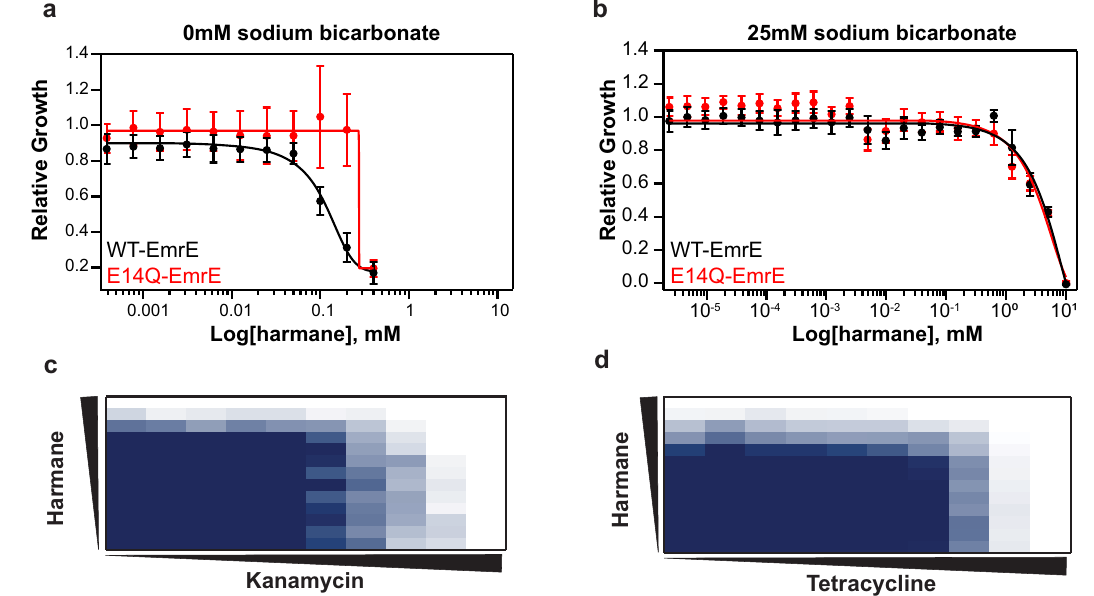
Fig. 6 | Harmane dissipates the proton gradient of bacterial cells. a , b Relative growth was plotted as a function of harmane concentration in the presence of 25mM sodium bicarbonate ( b ) for MG1655 Δ emrE E. coli cells expressing WT- (black)andnonfunctional,E14Q-EmrE(red).ComparedtotheresultsofIC 50 assays without bicarbonate ( a ), bicarbonate diminishes the susceptibility phenotype in E. coli expressing WT-transporter. Error from the triplicate measurements is dis- played as the standard deviation. MG1655 Δ emrE E. coli expressing WT-EmrE were grown in the presence of harmane as an adjuvant with kanamycin ( c ) and